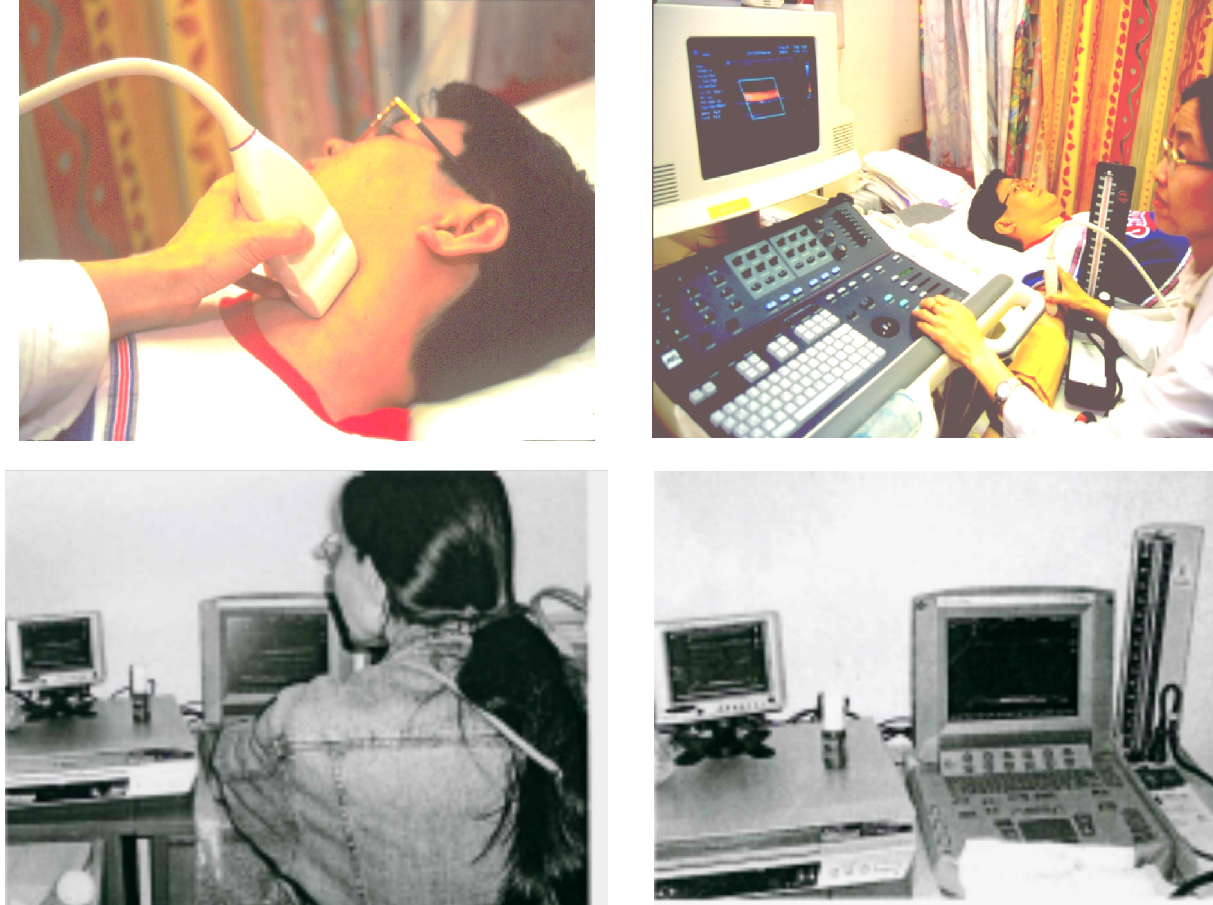
Figure 1. Ultrasound scan of carotid artery for carotid intima-media thickness and brachial endothelium-dependent dilation (endothelial function), using an ultrasound console ( above ); or a portable ultrasound machine at field work in northern China ( below